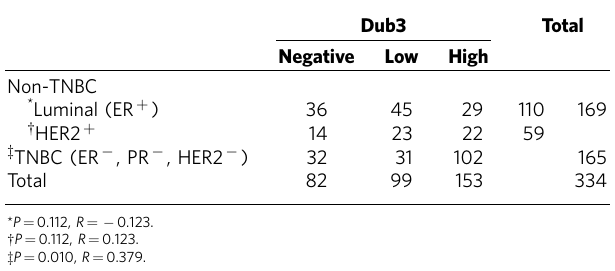
Table 2 | Expression of Dub3 in different subtypes of breast tumour specimens.